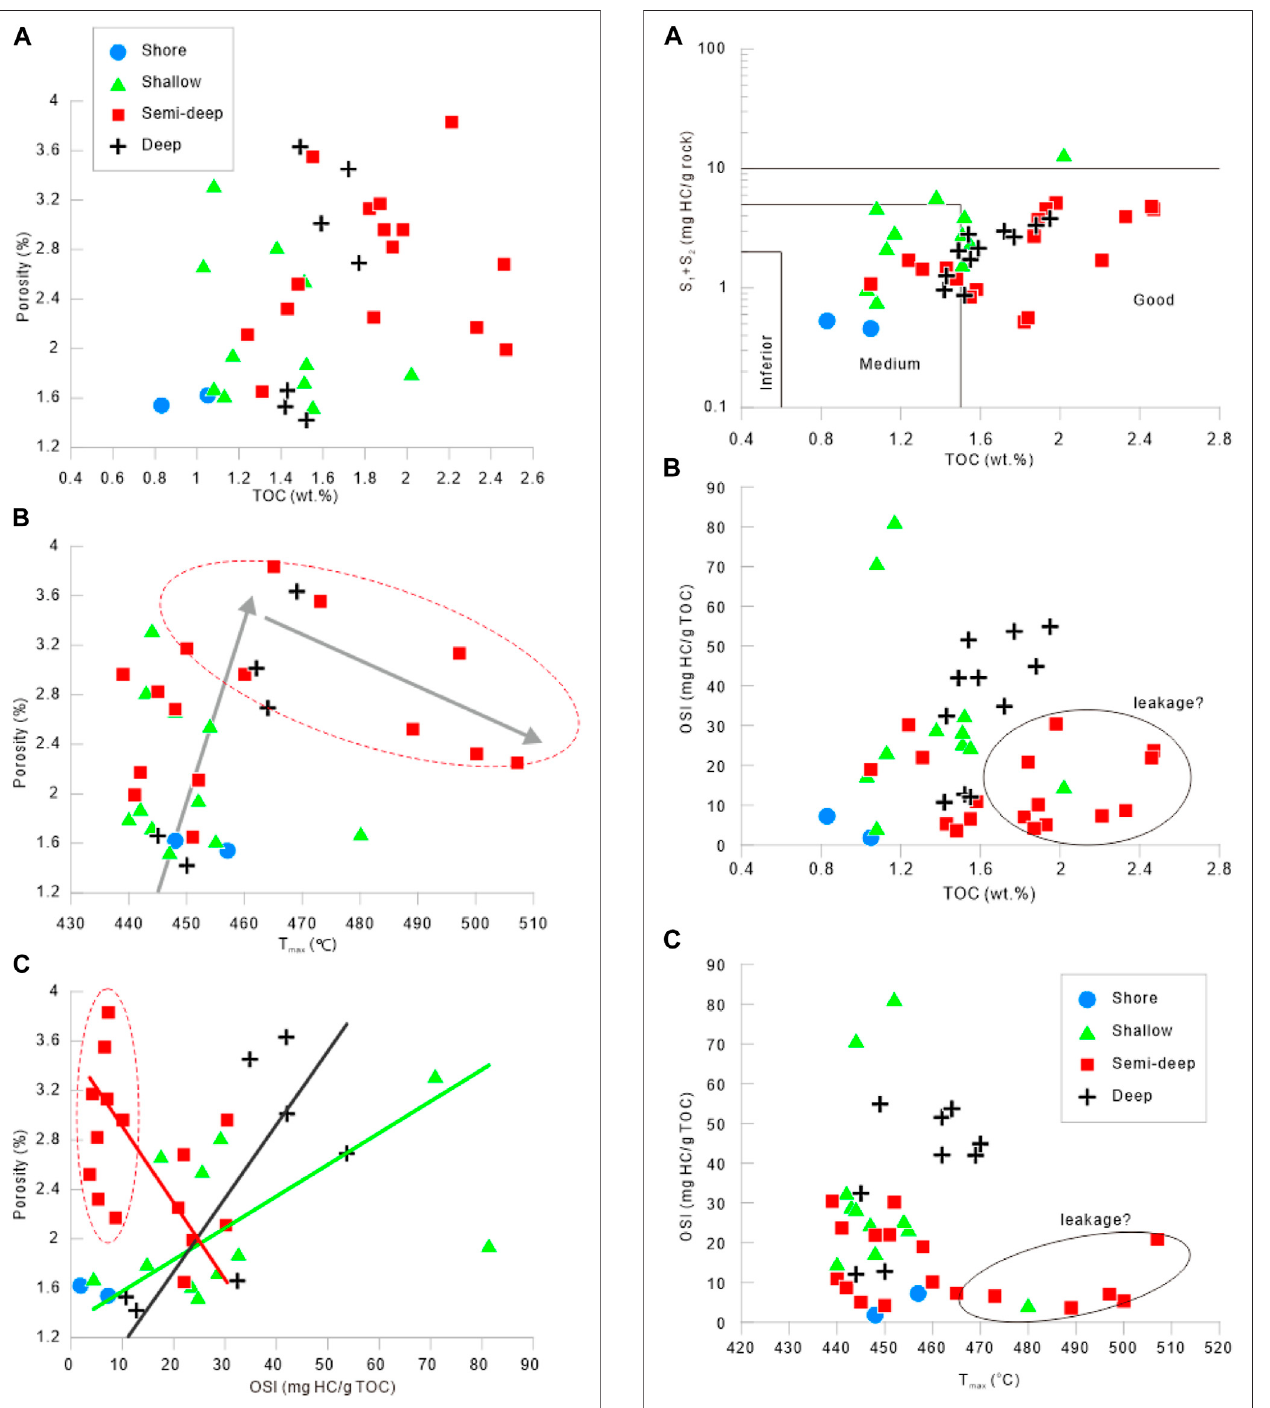
FIGURE 11 | Cross plots of (A) TOC content with porosity (B) T max with porosity, and (C) OSI (oil saturation index) with porosity in the black shale of the Dongyuemiao